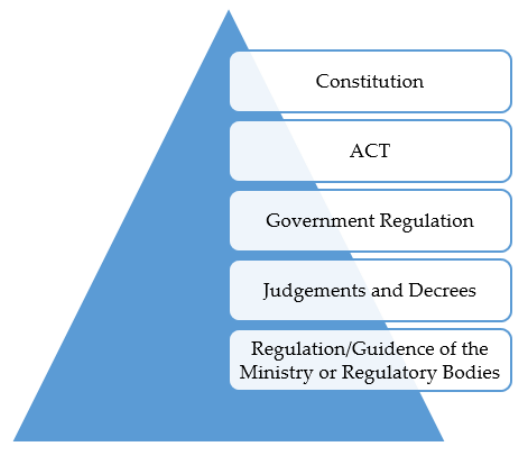
Figure 4. Hierarchy of the Laws in Bangladesh.